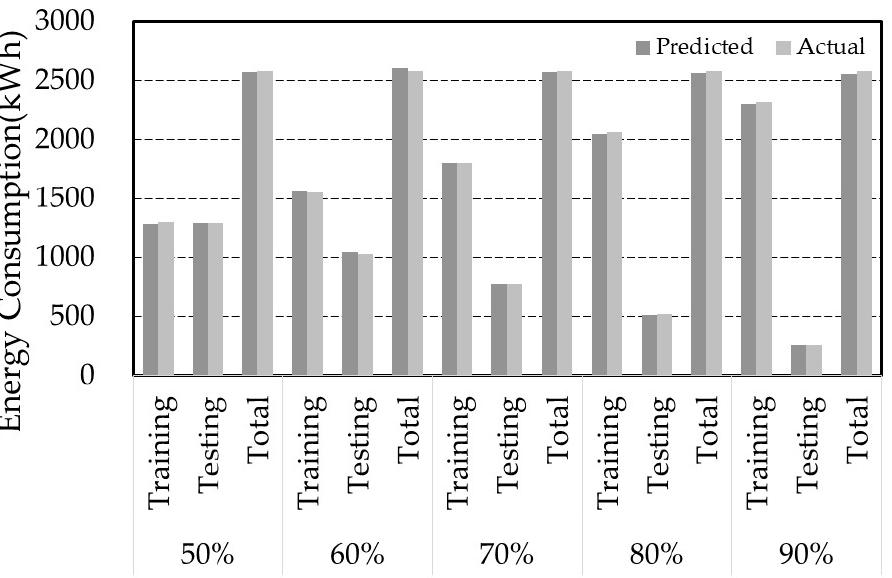
Figure 5. Total air handling unit energy consumption forecasting results. Table 4. Error rate of the total air handling unit energy consumption forecasting results.